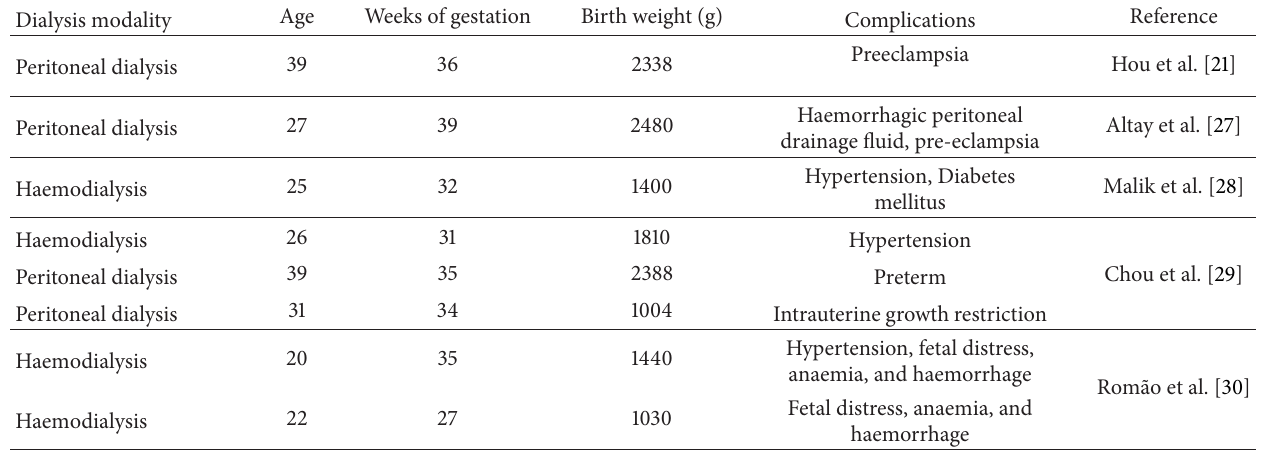
Table 1: Cases of live births in dialysis patients with systemic lupus erythematous in the